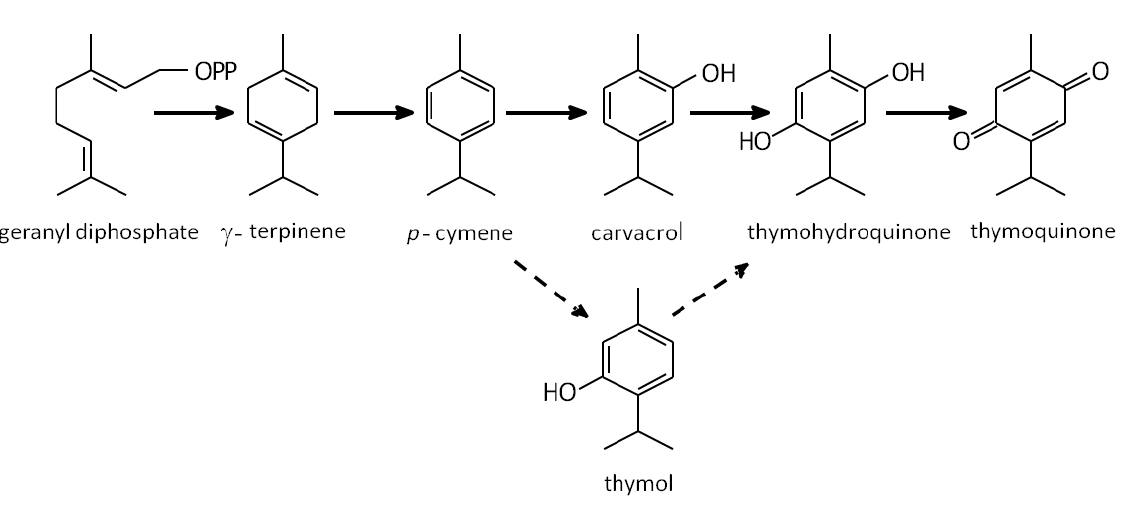
Figure 3. Proposed biosynthetic pathway to thymoquinone in N. sativa seed. The pathway is based on the better-studied pathways in the Lamiaceae [40,41] and the accumulation of the putative precursors in developing N . sativa seed (Figure 2). Geranyl diphosphate is probably cyclized to γ-terpinene, aromatized into p -cymene and then followed by hydroxylations to carvacrol and thymohydroquinone and oxidation to thymoquinone (upper solid arrows). In species and chemotypes accumulating thymol instead of carvacrol, hydroxylation to thymol as an alternative biosynthetic pathway is proposed (broken